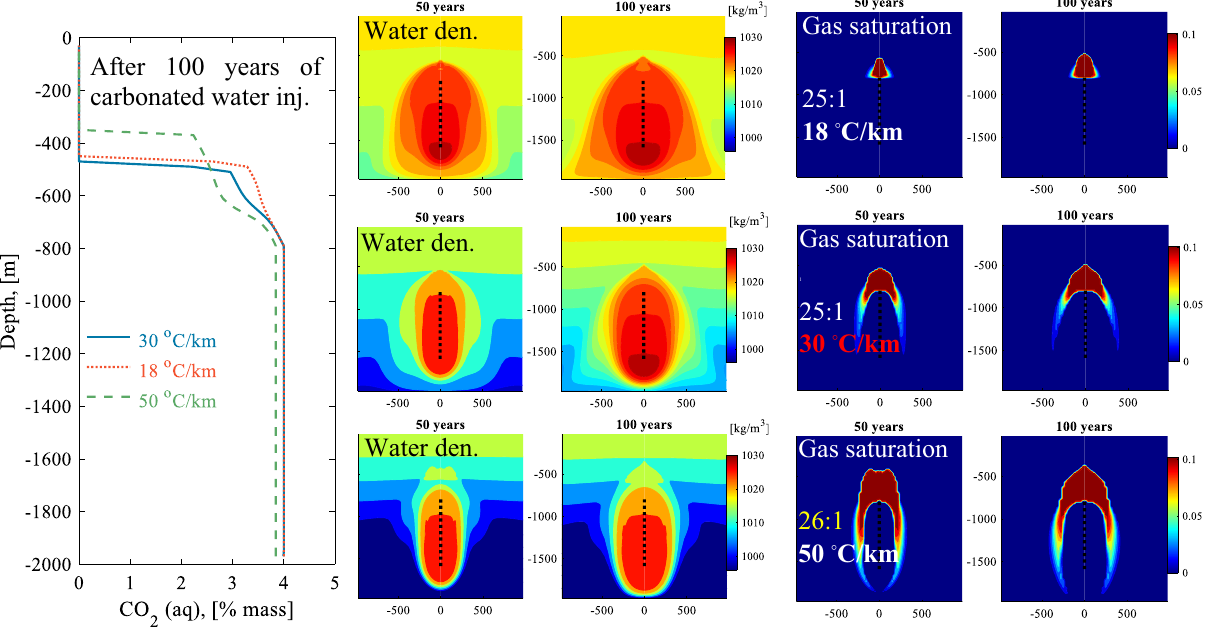
Figure 4. Left plot: A comparison of CO 2 concentration profiles at the well location (r = 0) as a function of depth after 100 years of injection for three temperature gradients of 18, 30 (reference case) and 50 °C/km. The water to CO 2 injection mass ratio is 25:1 for the 18, and 30 °C/km gradient, and 26:1 for the 50 °C/km gradient. Center and right plots: 2D cross-sections for the water density and the gas saturation, which is the mass fraction of exsolved CO 2 in the pore fluids, for the three temperature gradients after 50 and 100 years of carbonated water